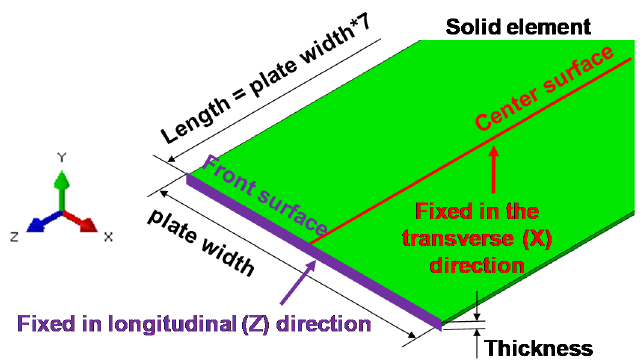
Figure 3. Size and boundary conditions of a steel plate in the finite element model.